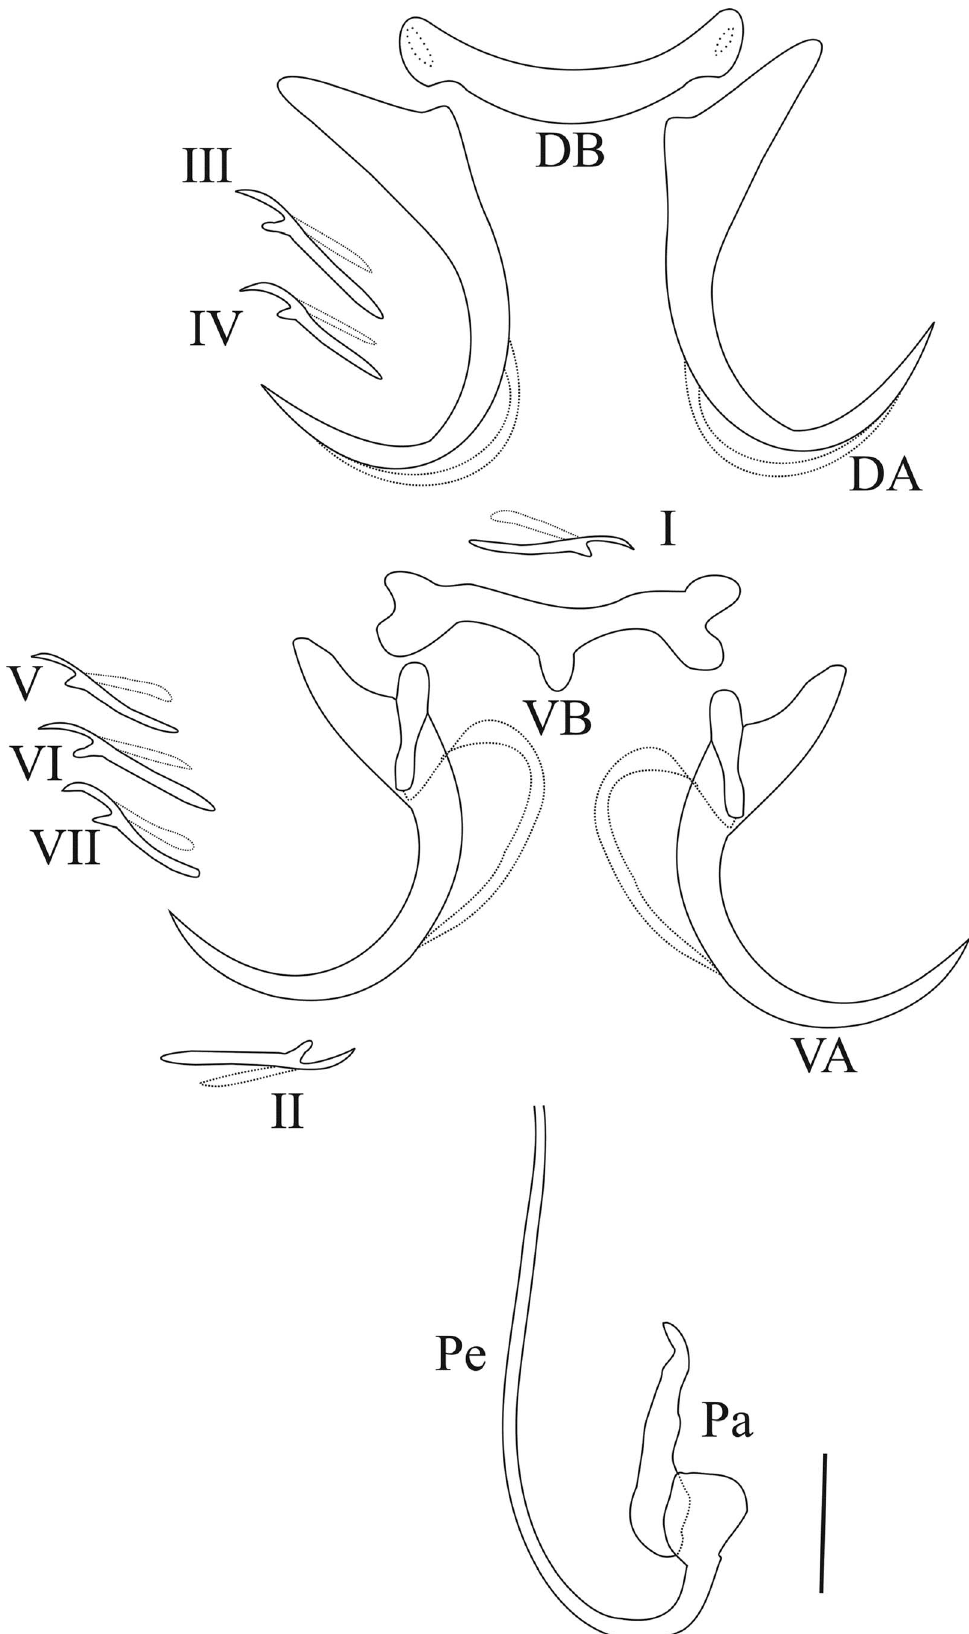
Figure 5. Hard parts of Synodontella akengboi; D.A: dorsal anchor; D.B: dorsal transverse bar; V.A: ventral anchor; V.B: ventral transverse bar; I – VII: marginal hooks; Ap: accessory piece; Pe: penis. Scale bar = 10 l